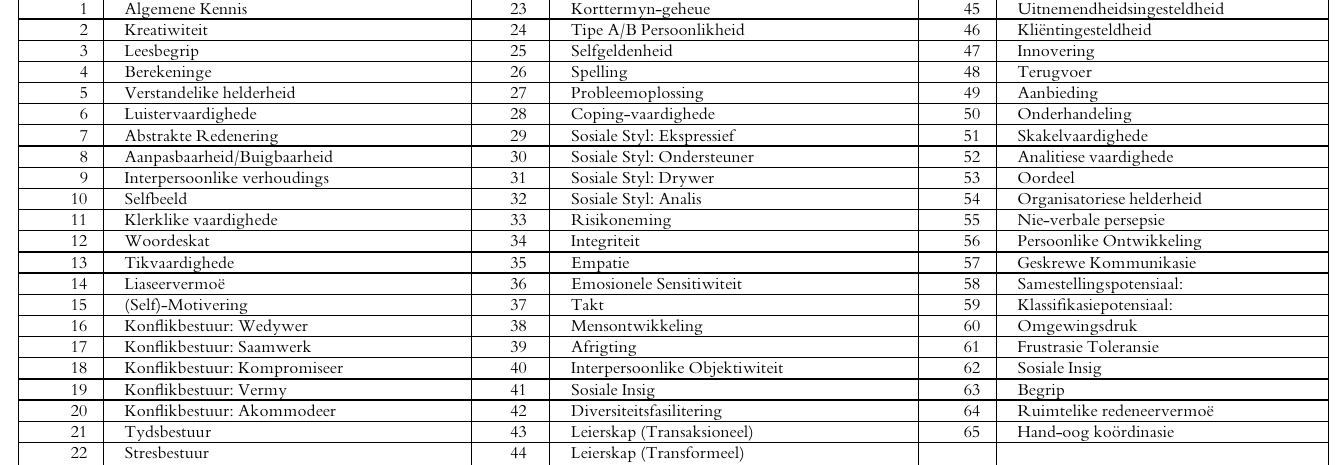
Figuur2:CSIPDimensies(Basiesebevoegdhede)